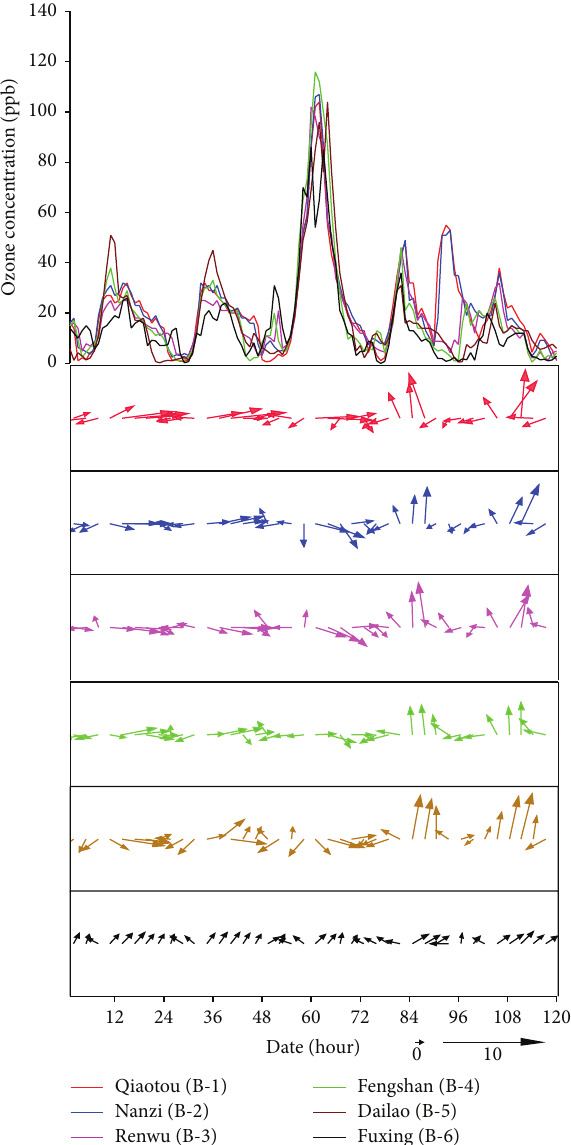
Figure 6: Observed O 3 concentrations and wind field between group (B group) ambient air quality monitoring stations during June 28 and July 2,